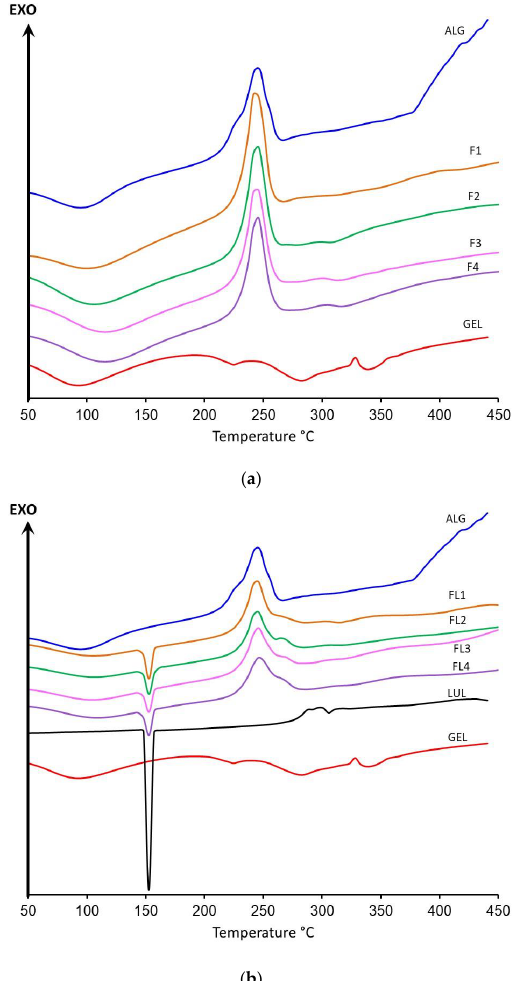
Figure 11. DSC thermograms for ( a ) ALG, GEL, and placebo formulations (F1 – F4) and ( b ) ALG, GEL, LUL and LUL-loaded formulations (FL1 – FL4). LUL and LUL-loaded formulations